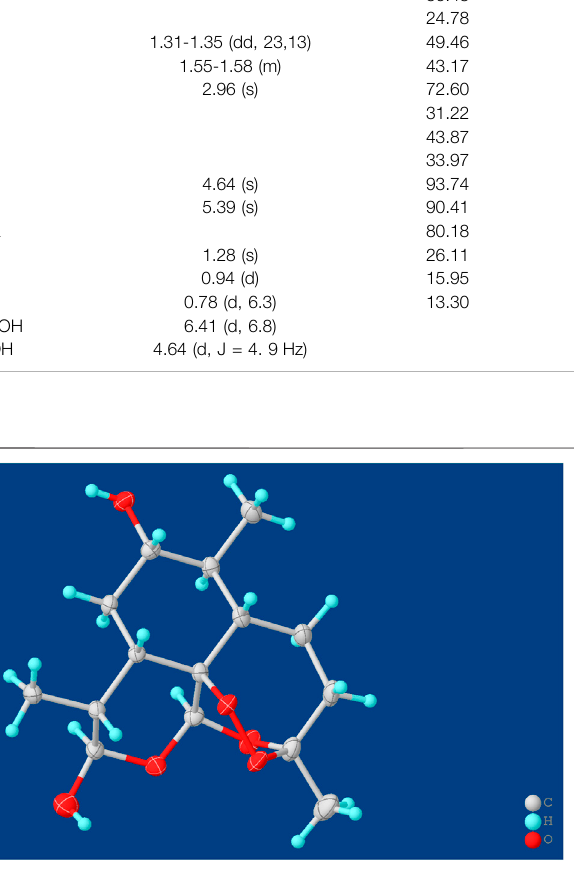
SCHEME 2 | X-ray crystal structures of compound M1